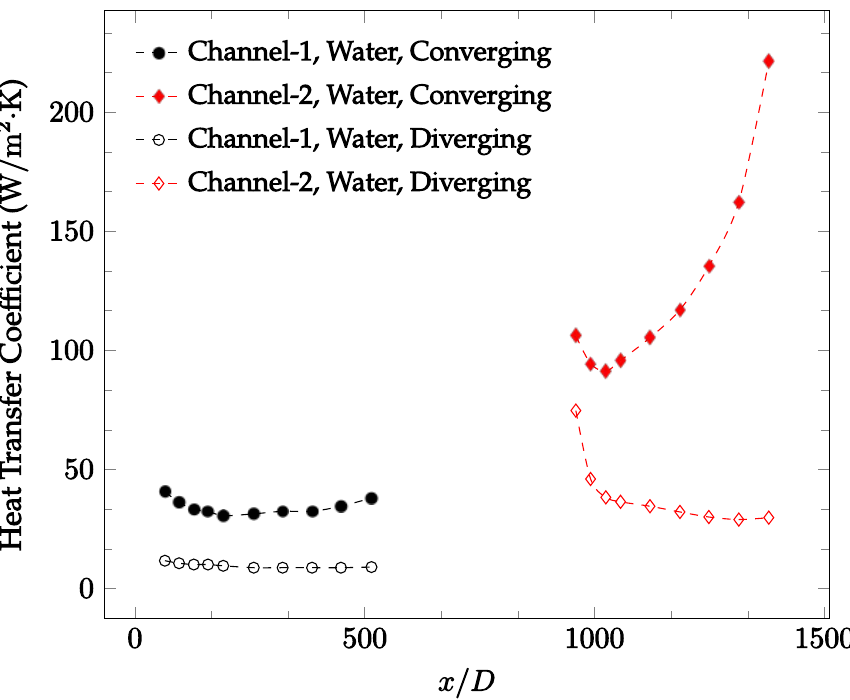
Figure 10. Change in convective heat transfer coefficient of deionized water as a function of dimensionless distance for a Reynolds numbers of 25. Converging and diverging nozzles are used as connectors.